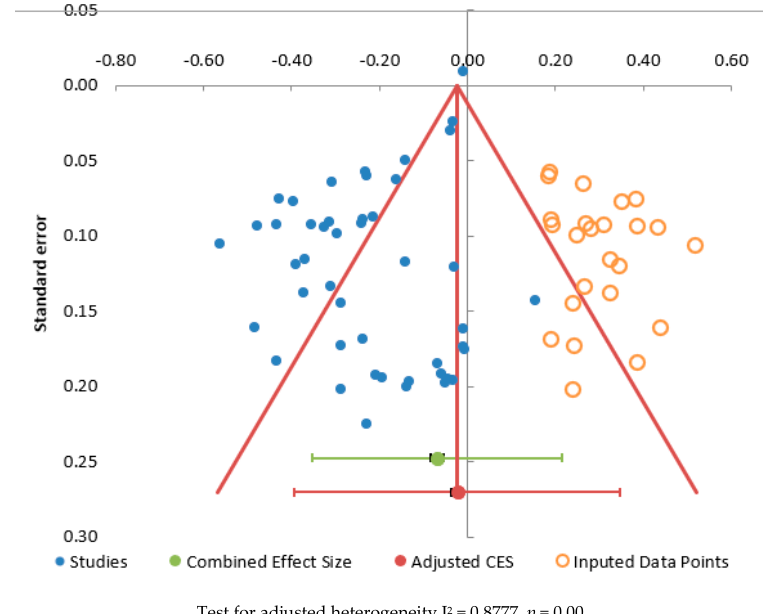
Figure 5. Funnel plot for effect size against standard error for percentage change in emotional eating score